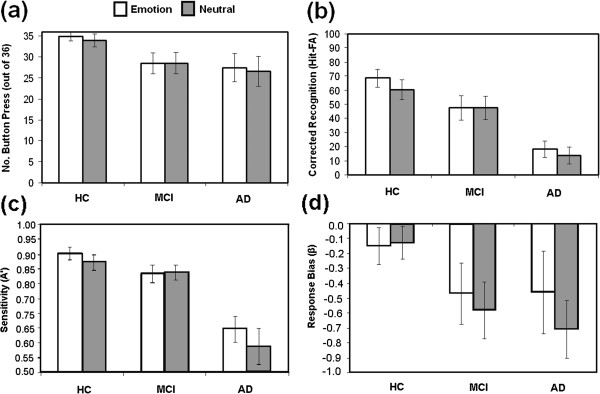
Behavioural data from the scanner and post-scanner emotional memory tests from the three groups of participants (error bars represent the standard errors of the mean). (a) Number of button presses while participants observed the images within the fMRI scanner. (b) Corrected recognition in the post-scan memory test. (c &d) Variables of the Signal Detection Theory which inform on sensitivity (c) and response bias (d).